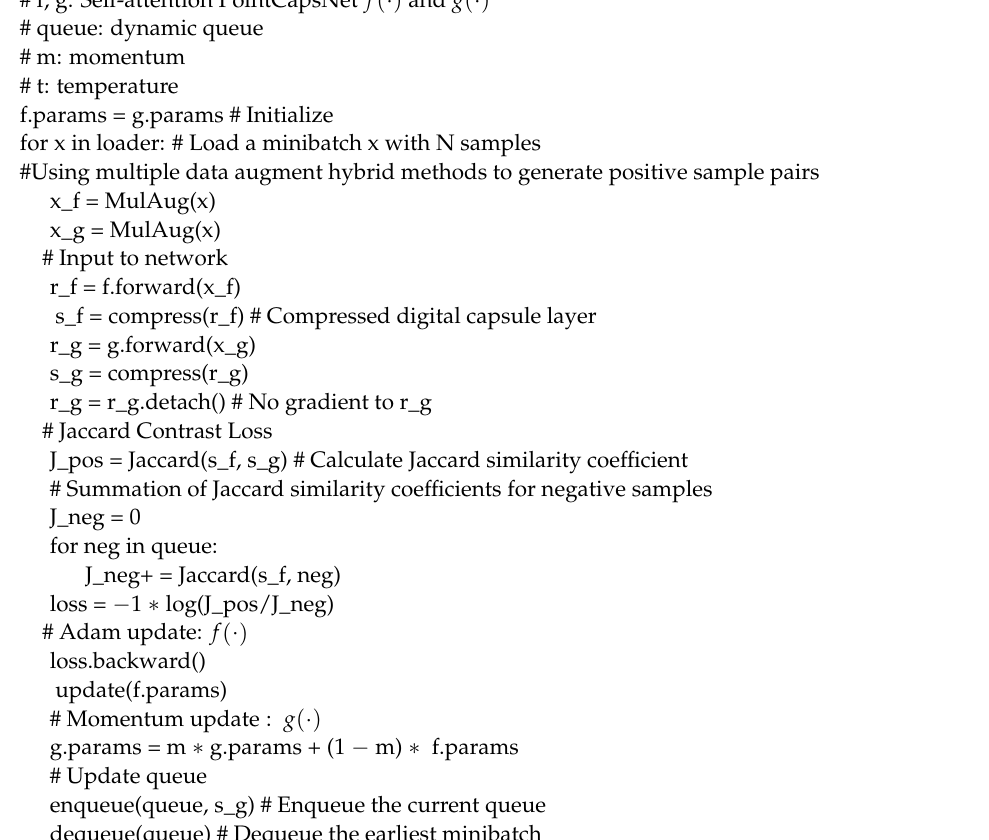
Algorithm 1 Pseudocode in Momentum Contrast Learning in a PyTorch-like